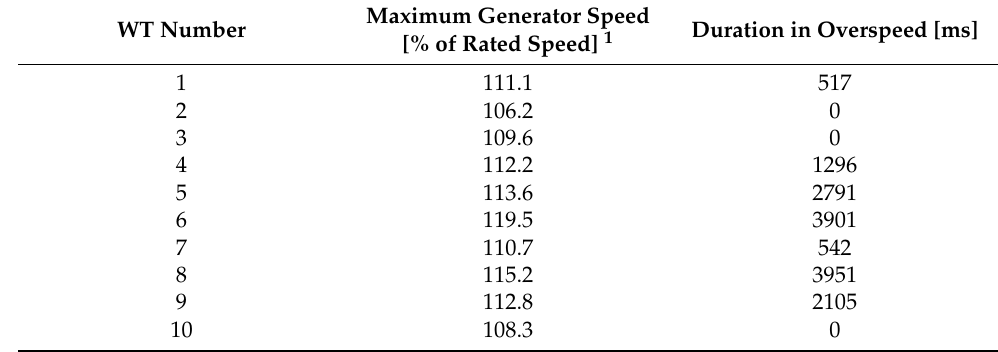
Table 4. Results of scenario II. Maximum speed and duration in overspeed for all simulated WTs.